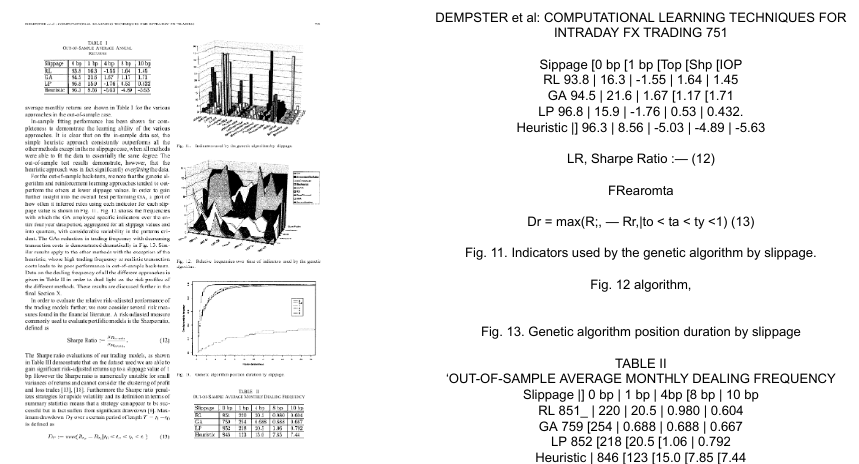
Fig. 13. Genetic algorithm position duration by slippage TABLE II ‘OUT-OF-SAMPLE AVERAGE MONTHLY DEALING FREQUENCY Slippage |] 0 bp | 1 bp | 4bp [8 bp | 10 bp RL 851_ | 220 | 20.5 | 0.980 | 0.604